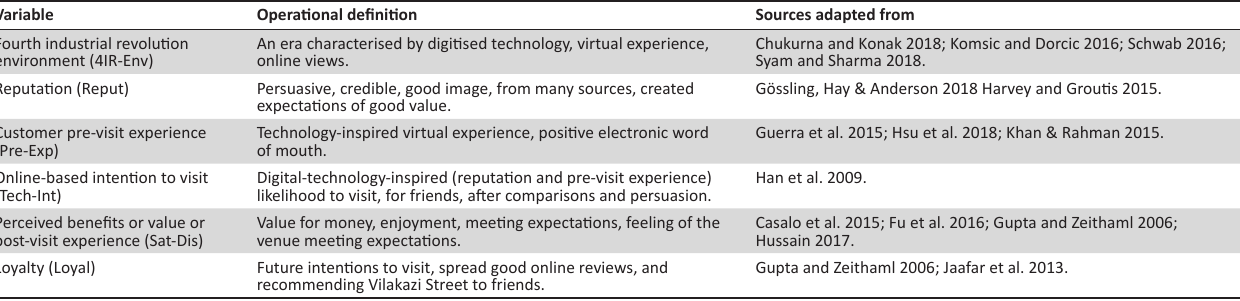
TABLE 1: Variables, operational definitions and